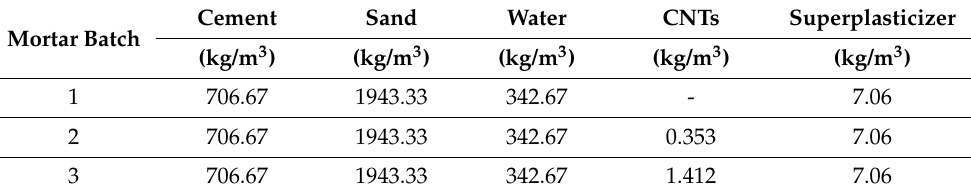
Table 3. Mortar Mix